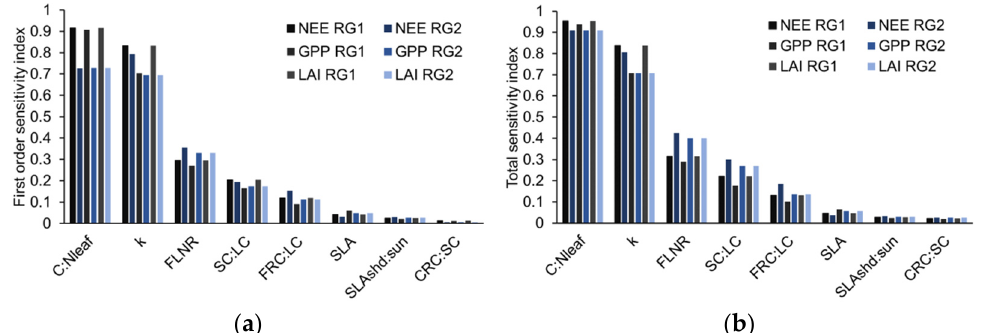
Figure 2. ( a ) First-order sensitivity index and ( b ) total sensitivity index in the ranges of ±10% per- turbation and ±20% perturbation of parameter